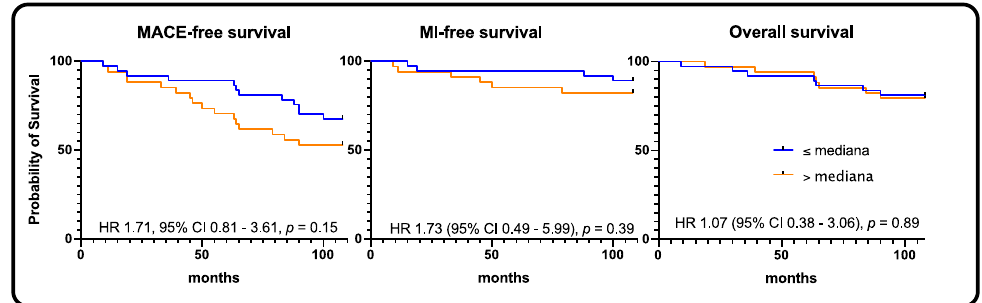
Figure 4 . Acute coronary syndrome population—Kaplan–Meier curves for MACE, myocardial